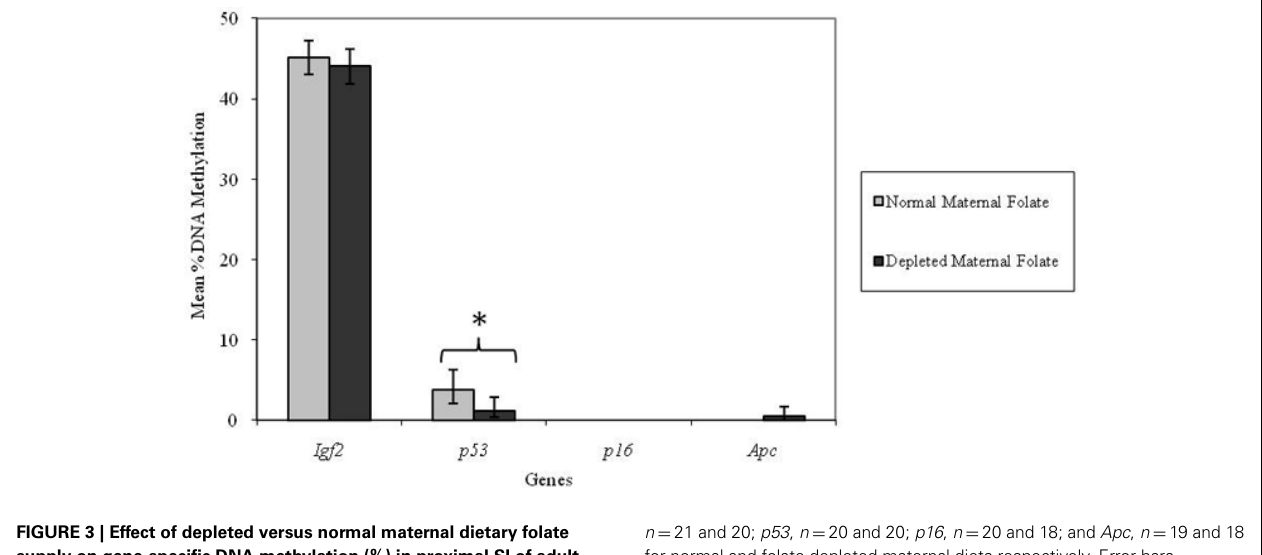
n = 21 and 20; p53 , n = 20 and 20; p16 , n = 20 and 18; and Apc , n = 19 and 18 for normal and folate-depleted maternal diets respectively. Error bars represent 95% confidence intervals. * p < 0.05.